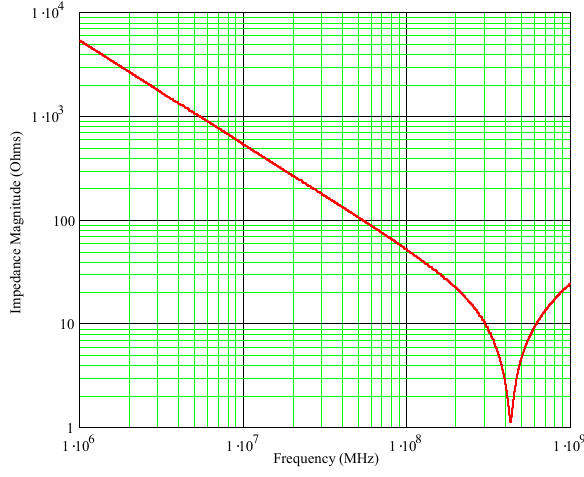
Figure 5: Typical impedance observed from IC